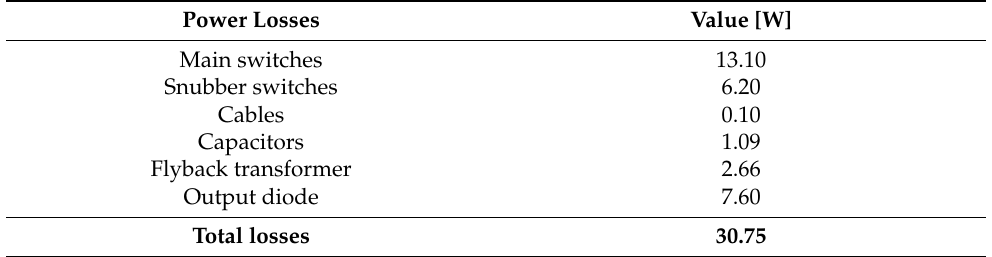
Table A1. Simulated power